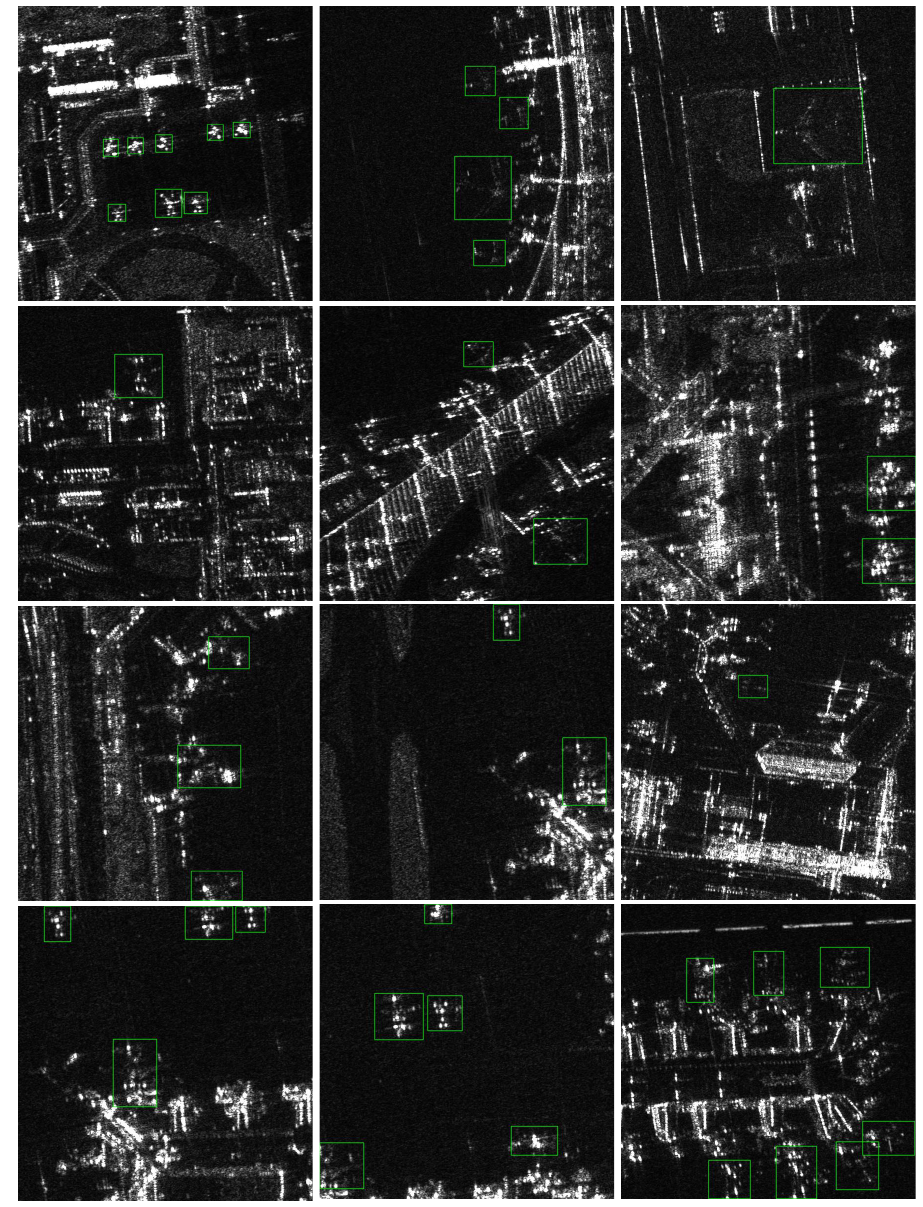
Figure 9. Examples in SAD. The green boxes are detected